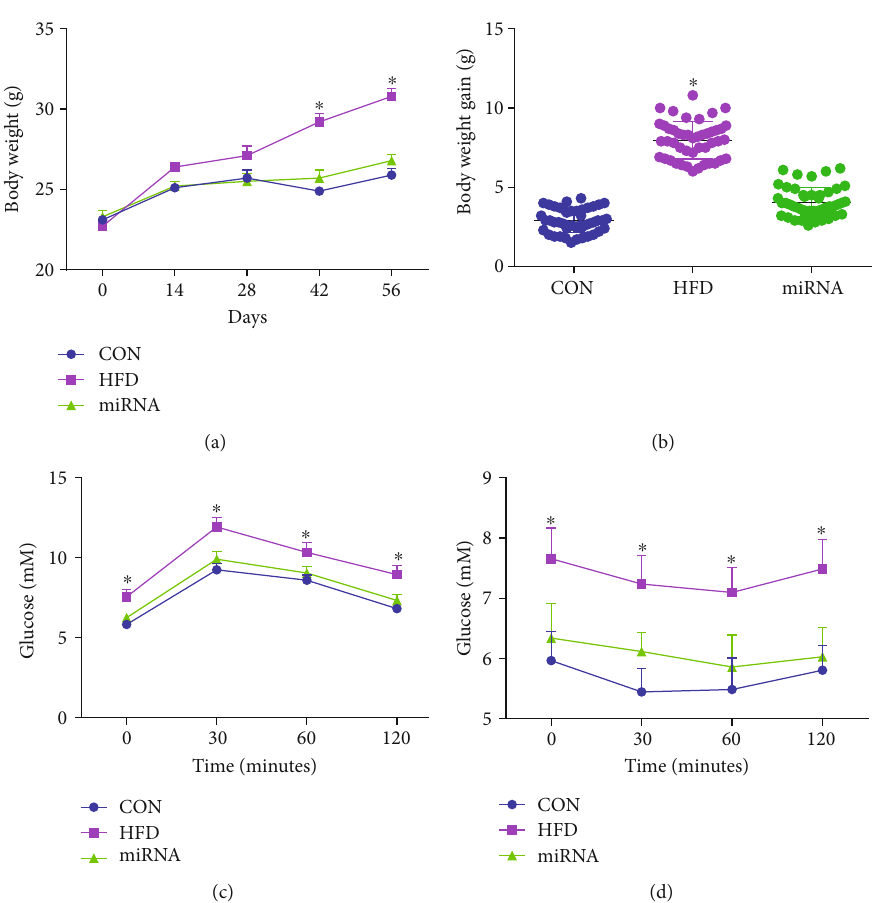
Figure 1: E ff ects of miRNA-10a-5p on body weight gain, IGTT, and ITT in high-fat diet-fed mice. (a) body weight; (b) body weight gain; (c) intraperitoneal glucose test; (d) insulin tolerance test. Data were expressed as Mean ± SEM . ∗ P < 0 : 05